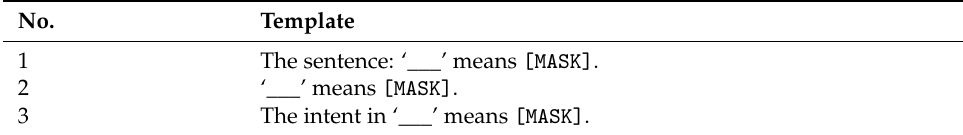
Table 4. Three types of template for cloze-style data